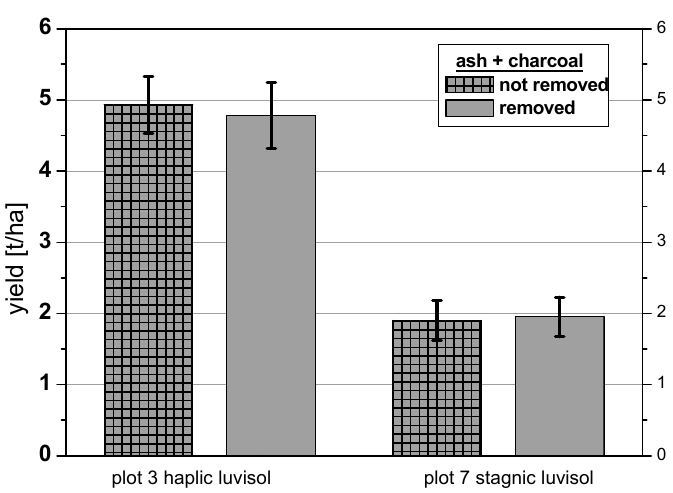
Figure 9. Crop yields (t/ha) of Triticum aestivum (winter wheat, modern variety), with and without removal of charcoal and ash (Ehrmann, et al. [29]).